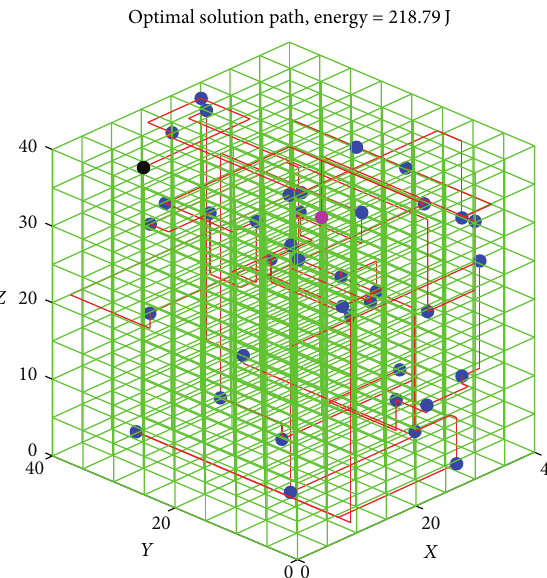
Figure 21: The best path given by the proposed